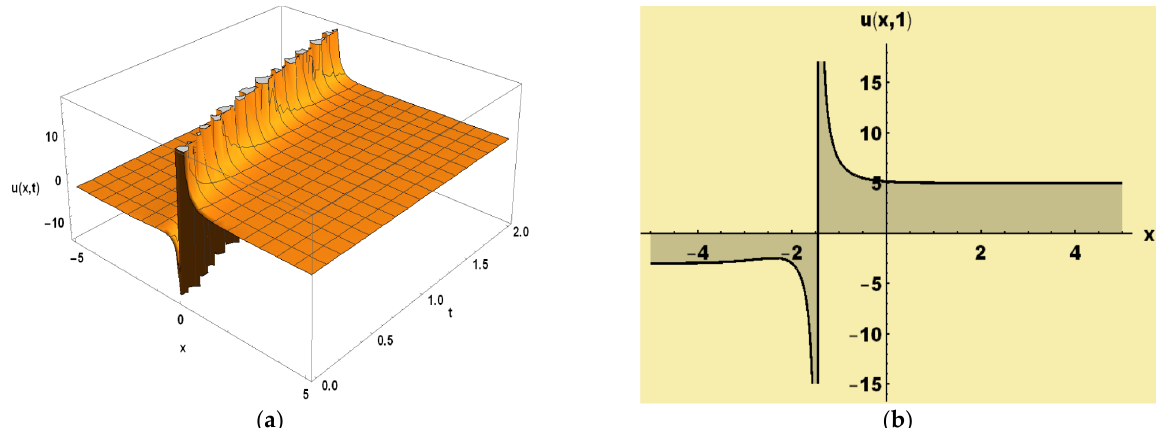
Figure 3. ( a , b ): Graphical analysis of Equation (20) for the values of the parameters A = 2, B = 3, E = 1, F = 1, H = 2, ψ = 2, δ = − 4.5, L = 1, α = 0.75, − 5 ≤ x ≤ 5, 0 ≤ t ≤ 2, for 3D and t = 1 for 2D plots.